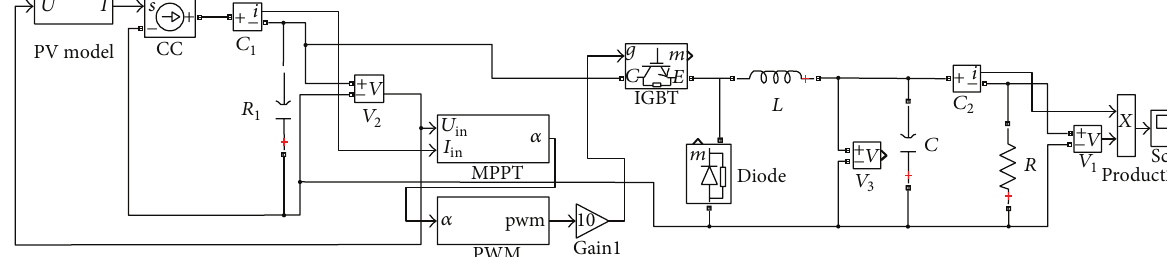
Figure 8: MPPT controller model.